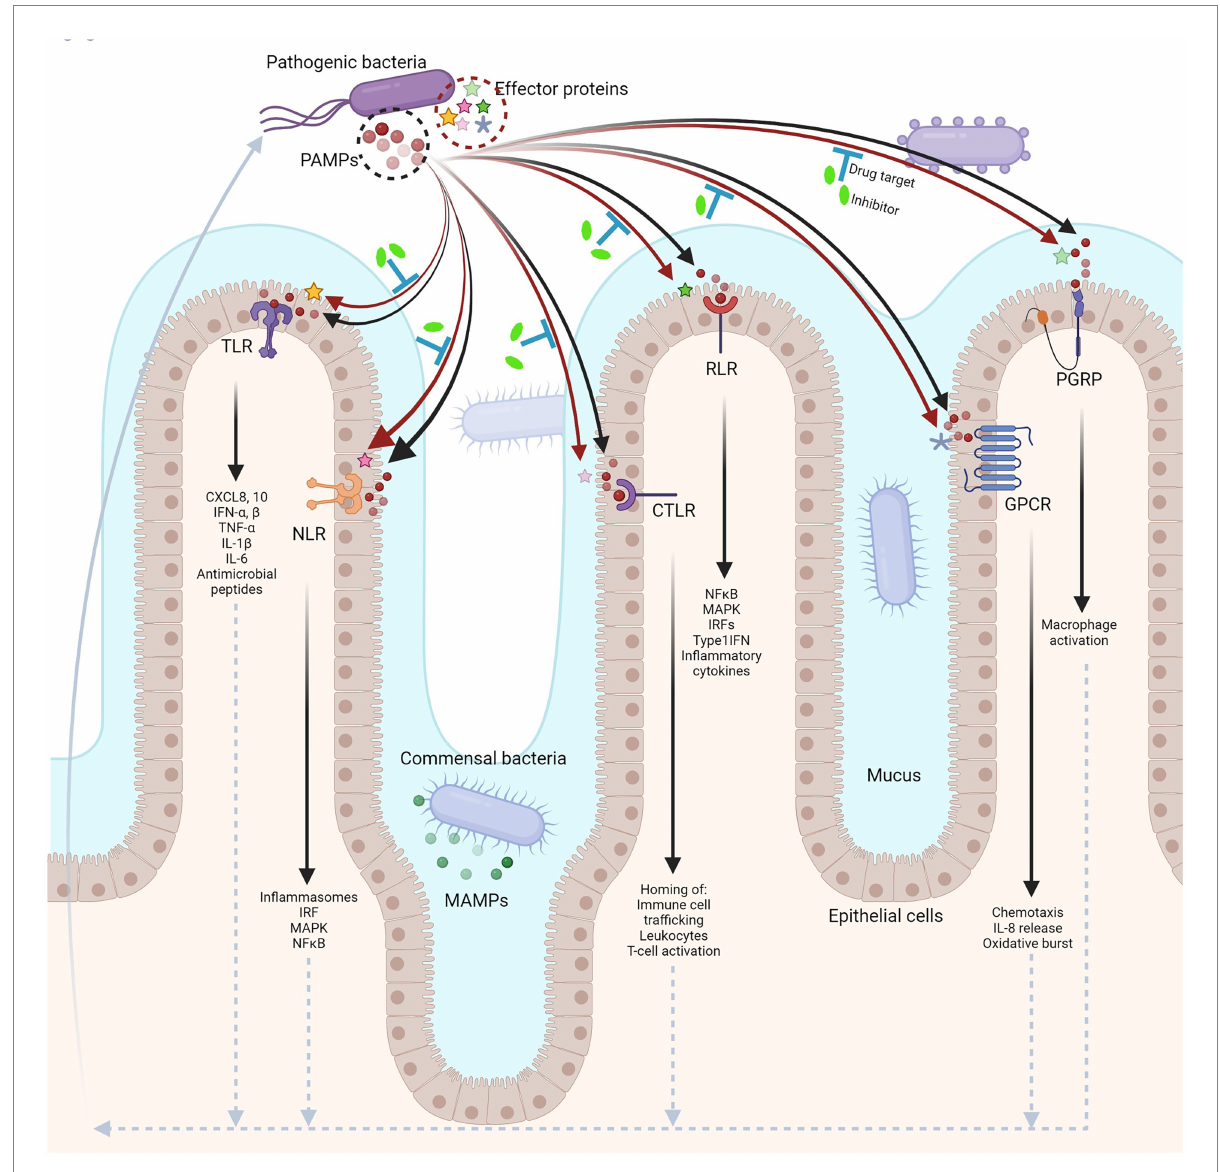
FIGURE 1 Host–microbe interface in the human gut. Different pattern recognition receptors (PRRs) in the host distinctly recognize PAMPs from pathogenic bacteria (black arrows), eliciting an immune response (upward arrow at far left, dotted arrows). In turn, pathogens secrete effector proteins that can modulate the pathways involved in host-immunity (red arrows). The enzymatic functions of effector proteins can be targeted for drug interventions contributing to alternative therapies against infections (blue ‘T’ bars; created with